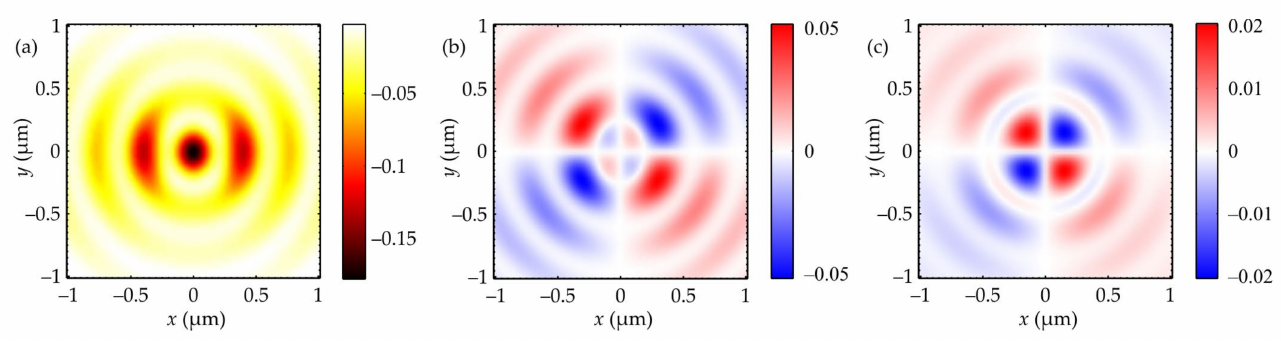
Figure 5. Stokes vector components s 1 ( a ), s 2 ( b ), and s 3 ( c ) at a distance λ before the focal plane.